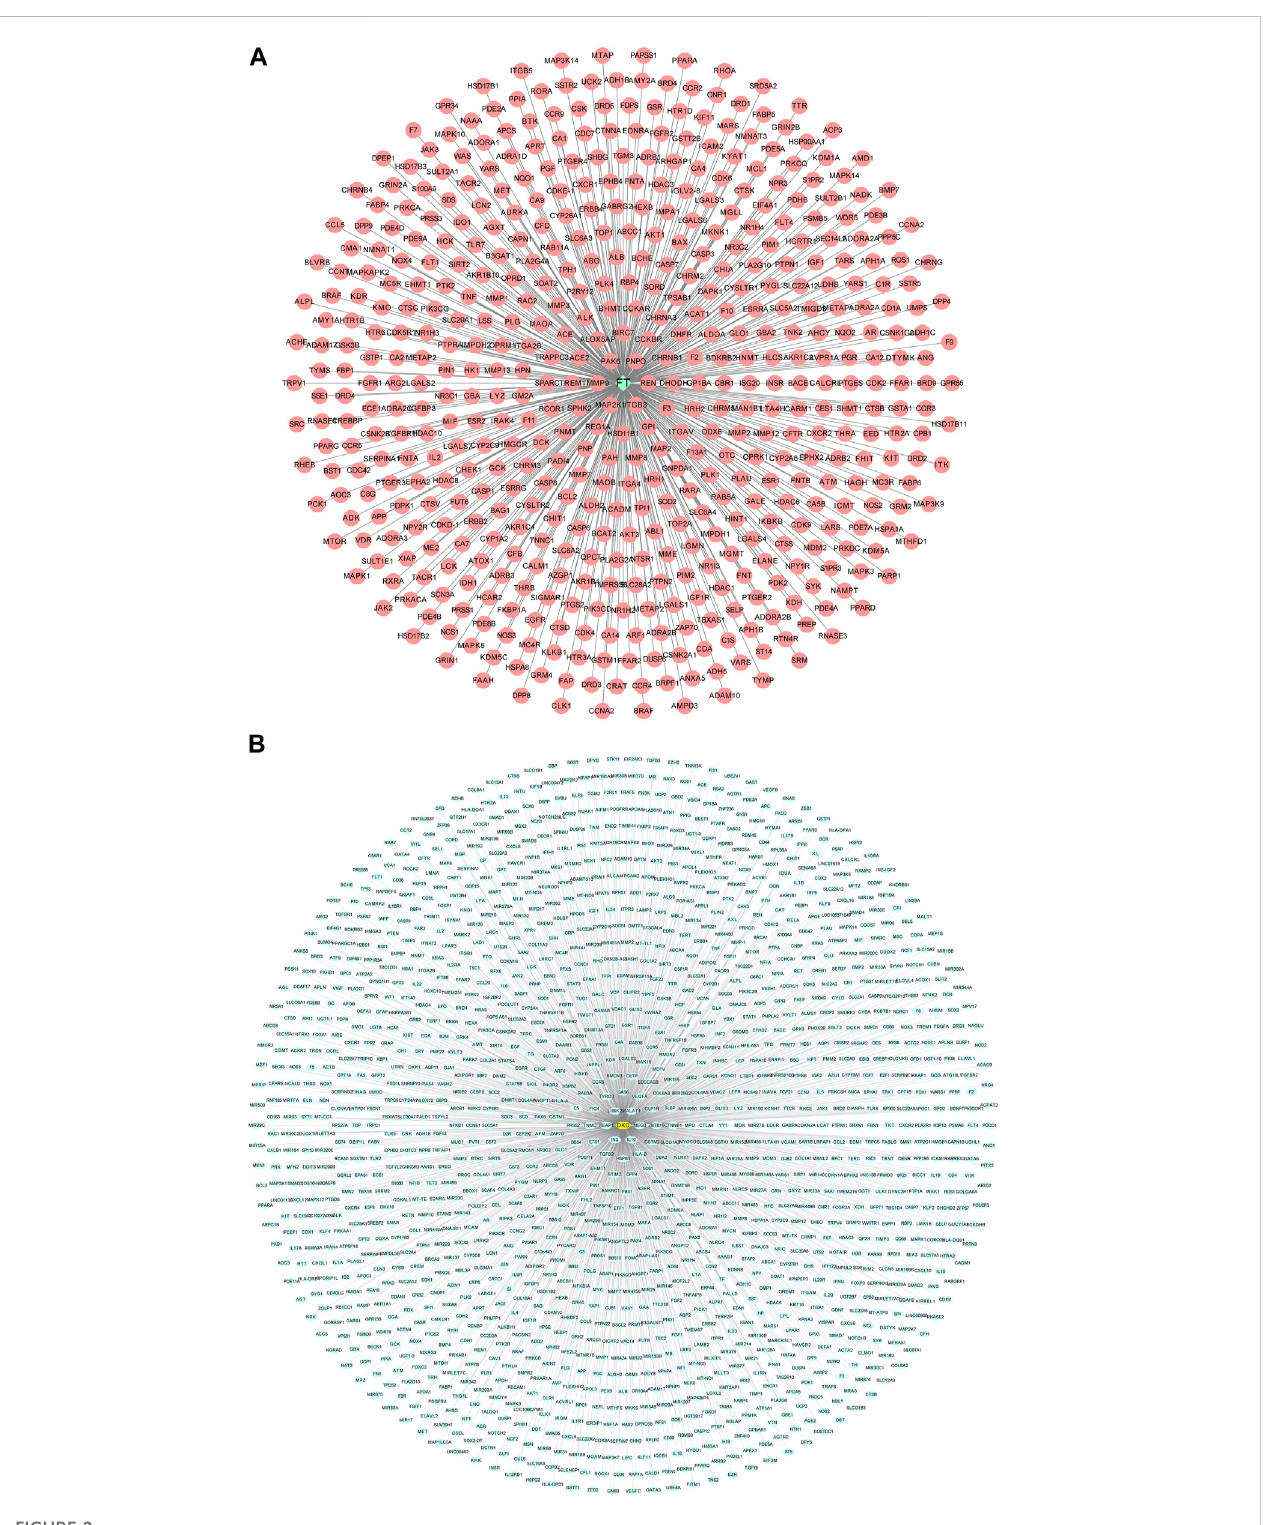
FIGURE 2 Compound-target network and disease-target network. (A) Forsythiaside-target network. Green diamond node represents Forsythiaside and red circular nodes represent corresponding targets. (B) DKD-target network. Yellow circular node represents DKD and green circular nodes represent corresponding targets. FT: Forsythiaside; DKD: diabetic kidney